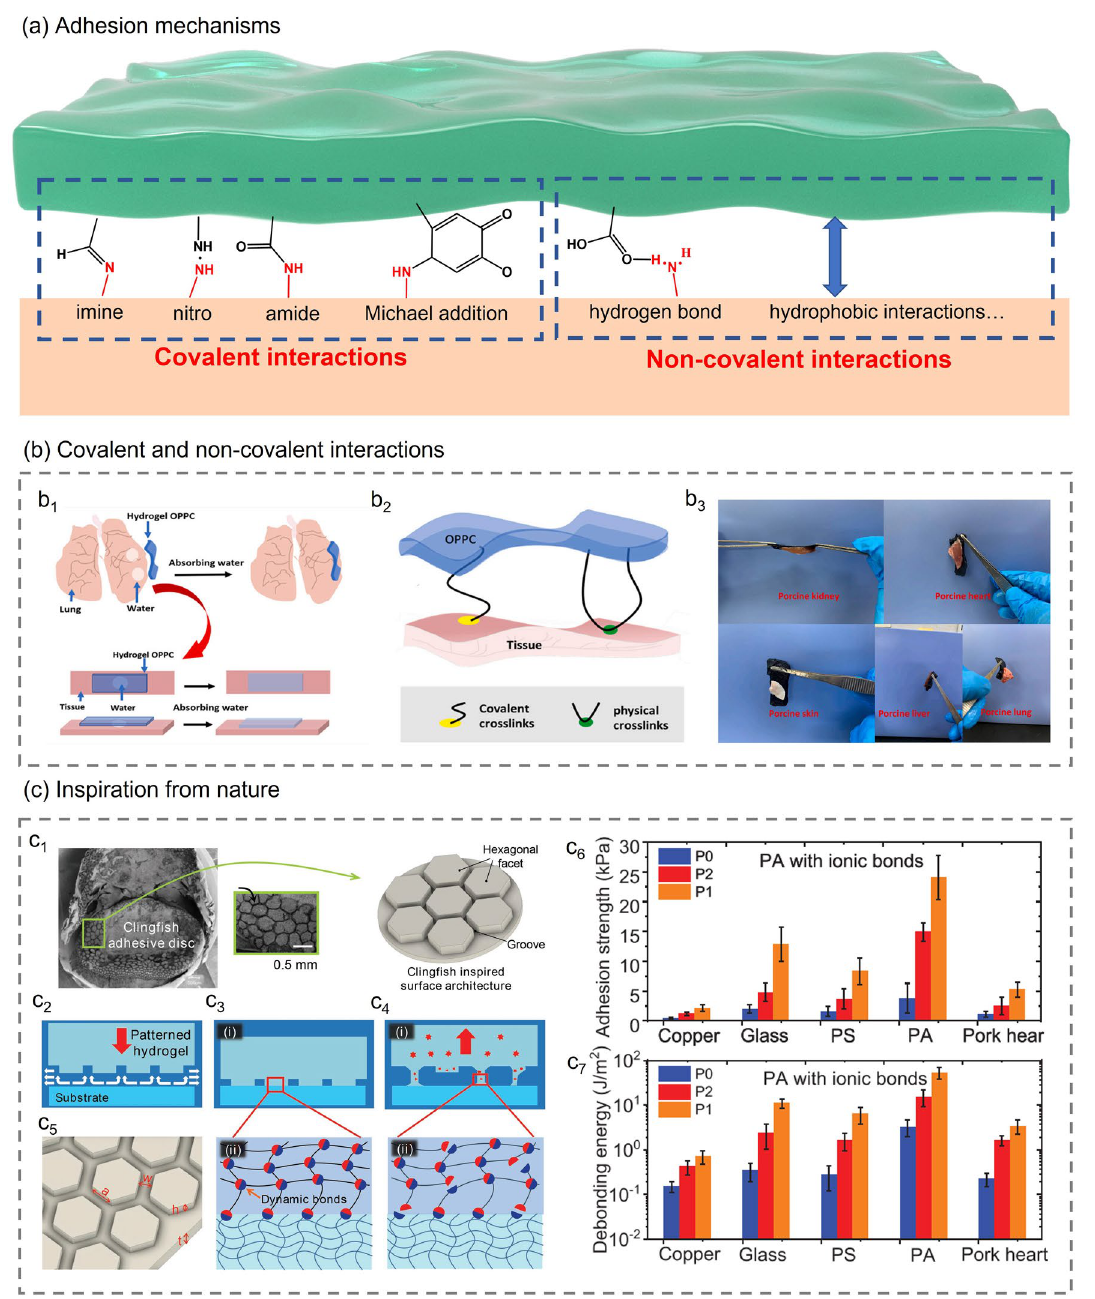
Fig. 5 a Representative covalent/non-covalent linkages formed between self-adhesive hydrogel and substrate. b Achieving self-adhesion by introducing covalent or non-covalent bonds [119]. b 1 The water on the surface of the wet organ is quickly absorbed by the hydrogel. b 2 Adhesion mode of hydrogel OPPC. b 3 OPPC hydrogels can easily adhere to the surface of various organs. Reproduced with permission. Copyright 2021, Elsevier. c Self-adhesive hydrogel inspired by nature [120]. c 1 Inspired from the geometry of the adhesive discs of clingfish. c 2 The grooves provide fast drainage channels. c 3 The dynamic bonds between hexagonal facets and the substrates. c 4 The breaking of dynamic bonds dissipates energy during deformation. c 5 The geometric size of hexagonal facets. c 6 Underwater adhesion strength, calculated from the ratio of the debond- ing peak force to the nominal surface area of the samples. ( c 7 ) Underwater debonding energy per unit area, calculated from the ratio of the area under the force–displacement curves to the nominal surface area of the sample. Sample P0 does not contain hexagonal facets, sample P1 and P2 have hexagonal facets with the length of 0.875 and 1.75 mm, respectively. Reproduced with permission. Copyright 2018, John Wiley and